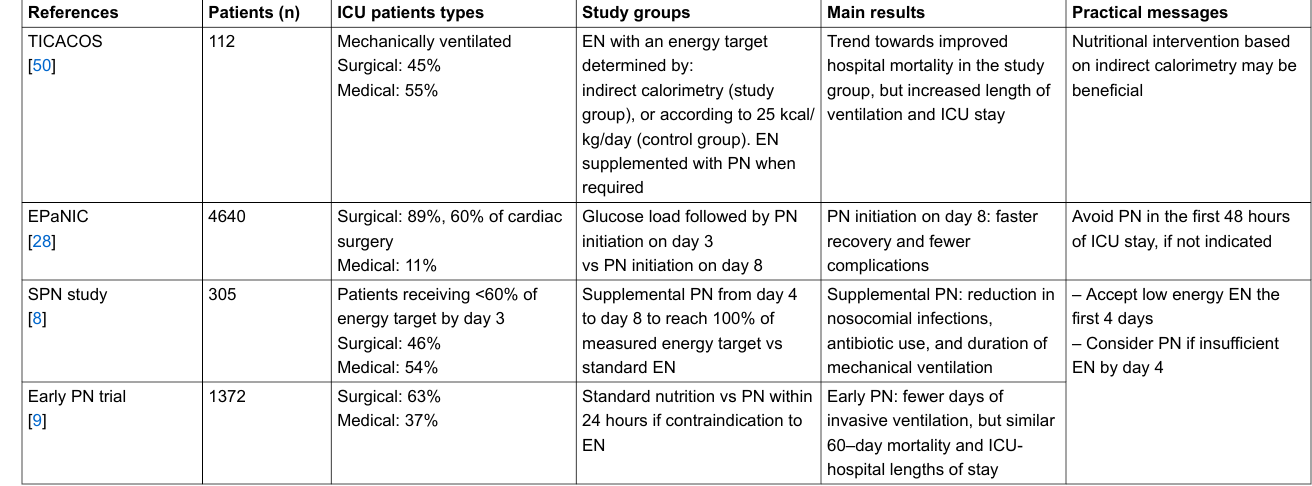
Table 1: Prospective randomised controlled trials evaluating the clinical outcome of supplemental parenteral nutrition (PN) in intensive care units (ICU) patients. EN, enteral nutrition; GI, gastrointestinal; PN, parenteral